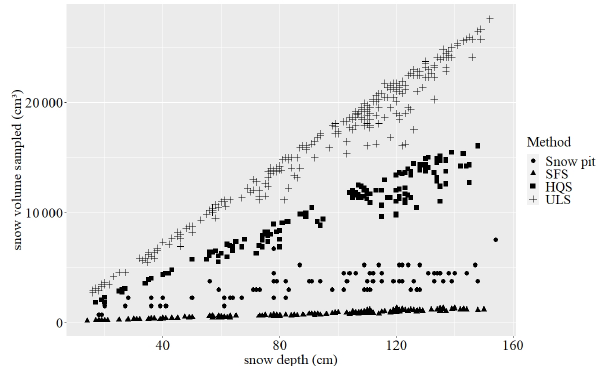
Figure 5. Volume of snow that was sampled using each SWE esti- mation method in relation to snow